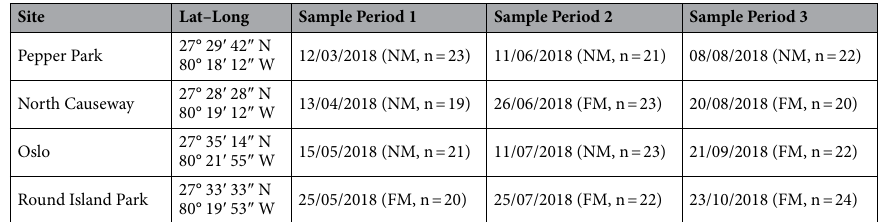
Table 2. Sampling sites and dates of collections from each site. Letters in parentheses following each sampling date refer to the lunar phase (NM = new moon, FM = full moon), followed by the sample